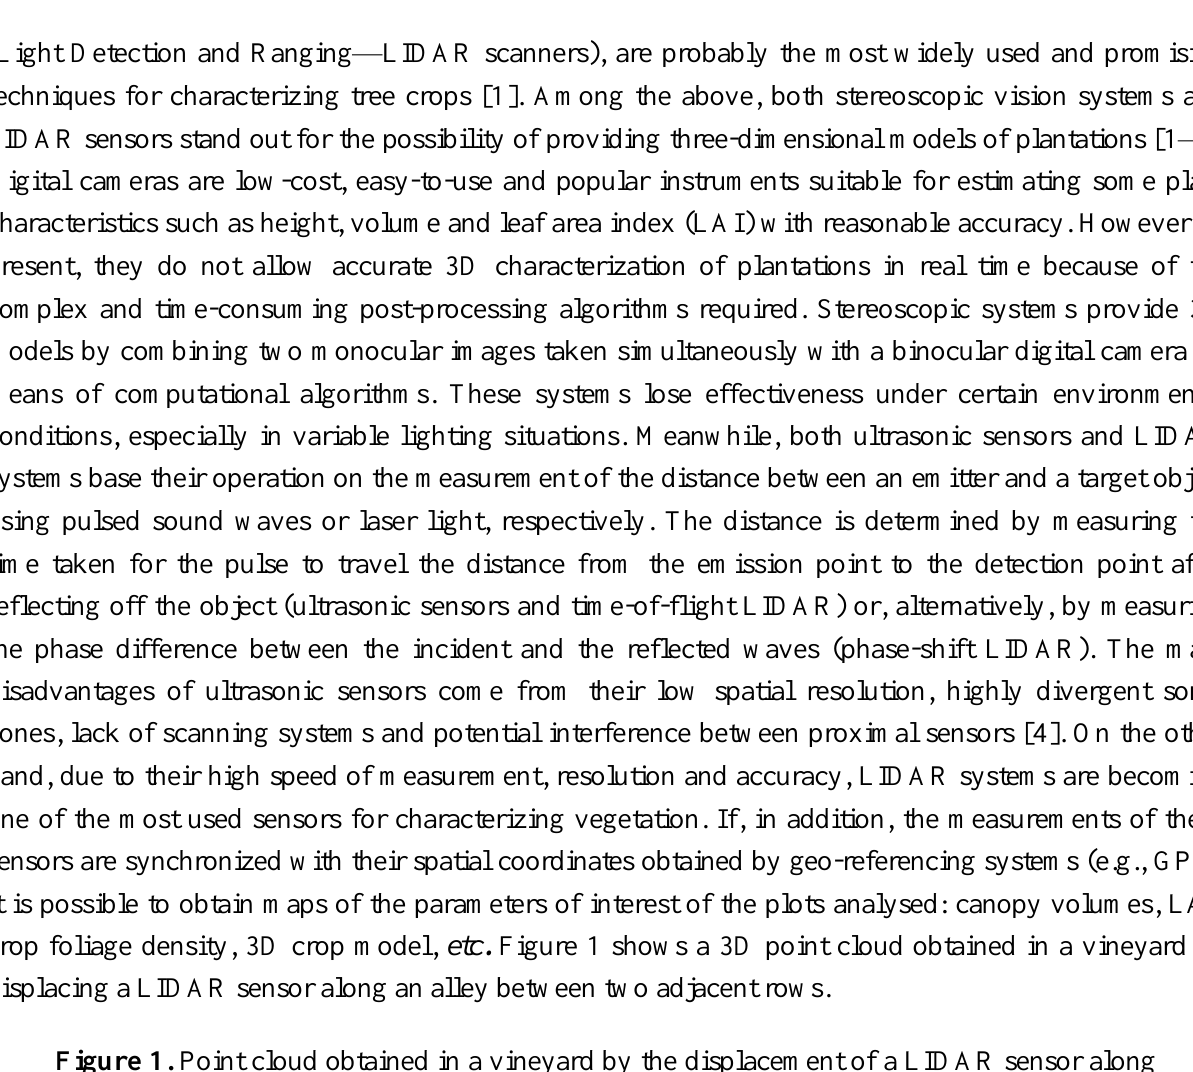
Figure 1. Point cloud obtained in a vineyard by the displacement of a LIDAR sensor along an alley between 2 rows (different colors correspond to different beam orientation